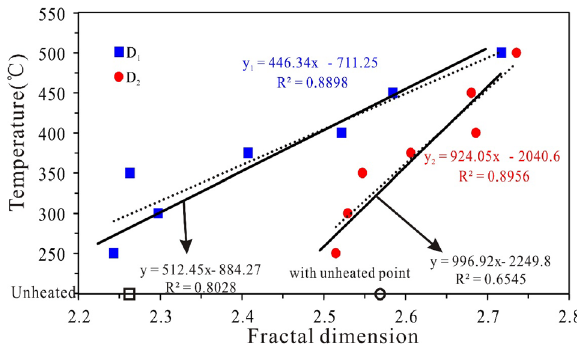
Fig. 4 Relationships between fractal dimensions and simulation tem- peratures in pyrolyzed oil